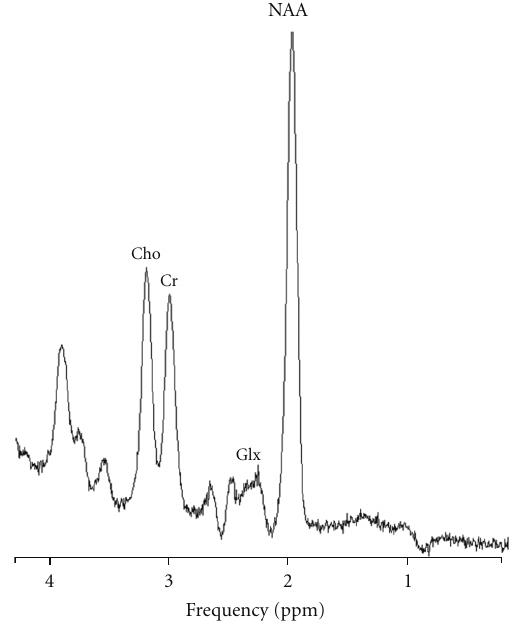
Figure 1: Representative proton ( 1 H) magnetic resonance spectrum of the anterior cingulate cortex at 3Tesla (TR = 2000 ms, TE = 135). Cho = Choline; Cr = Creatine; Glx = Glutamine + Glutamate; NAA = N-Acetyl Aspartate; ppm = parts per